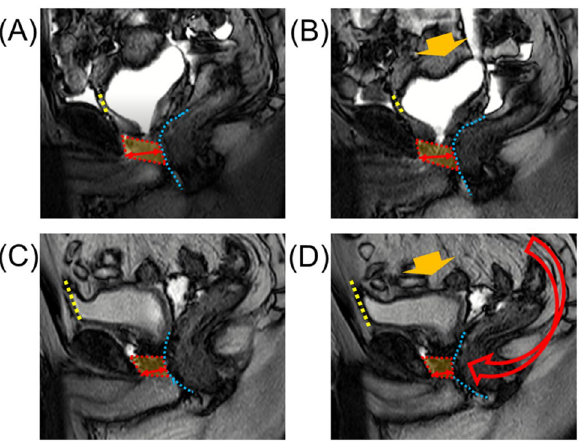
Figure 3. Dynamic mid-sagittal magnetic resonance imaging (MRI) after conventional robot-assisted radical prostatectomy (RARP): at rest ( A ) and with abdominal pressure ( B ). Dynamic mid-sagittal MRI after Retzius- sparing RARP: at rest ( C ) and with abdominal pressure ( D ). The thickness of the external urethral sphincter (two-headed red arrow) defined as the distance from the lowest point of the pubic bone to the anterior edge of the rectal wall (blue dashed line) was measured at rest and with abdominal pressure (orange arrow). The external urethral sphincter is indicated by the box surrounded by the red dashed